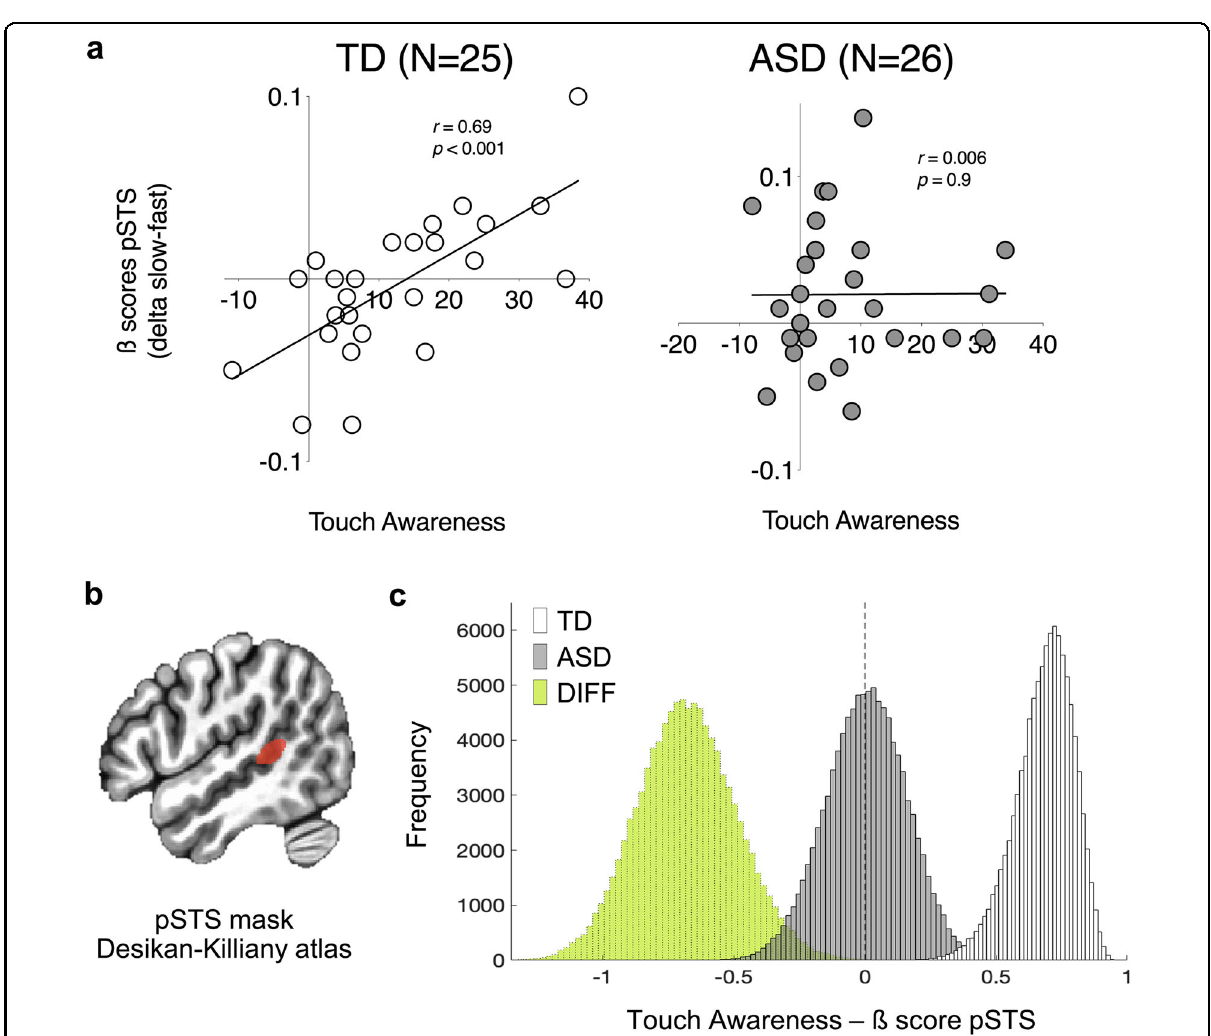
Fig. 3 Brain fi ndings. a Scatterplots showing Pearson ’ s correlations between the difference in ß-values for slow and fast touch and affective touch awareness scores in TD ( r = 0.69, p < 0.001) and ASD ( r = 0.006, p = 0.9). b Location of right pSTS mask, anatomically de fi ned using the Desikan – Killiany atlas. c Histograms from 100,000 bootstrap iterations computing correlations between right pSTS response and affective touch awareness correlations. Frequency distribution for bootstrap iterations for ASD (gray, 95% CI [ − 0.30, 0.30]), for TD (white, 95%CI [0.43, 0.86]), and for their respective difference (green, 95% CI [0.29, 1.04]). The distribution of the difference appears to be reliably smaller than zero, driven by reliable increase in correlation in TD, which was not observed in